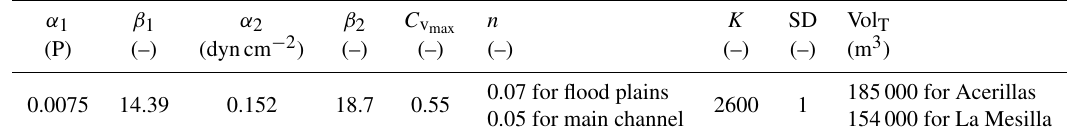
Table 2. Parameter values for reference models on Zegers (2017). P: poise; dyn: dyne. α 1 β